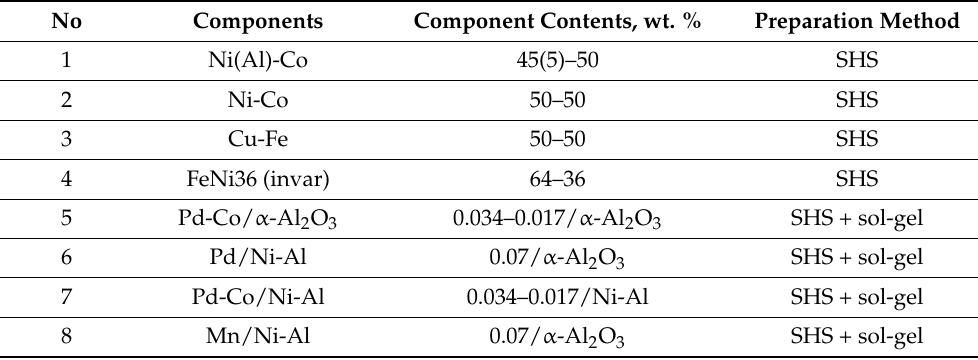
Table 1. Composition and method of preparation of catalytic converters synthesized for the study. No Components Component Contents, wt.